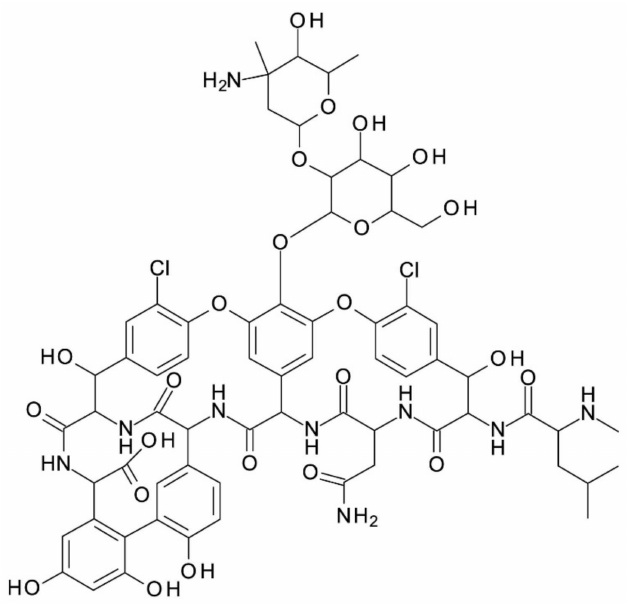
Figure 1. Chemical structure of